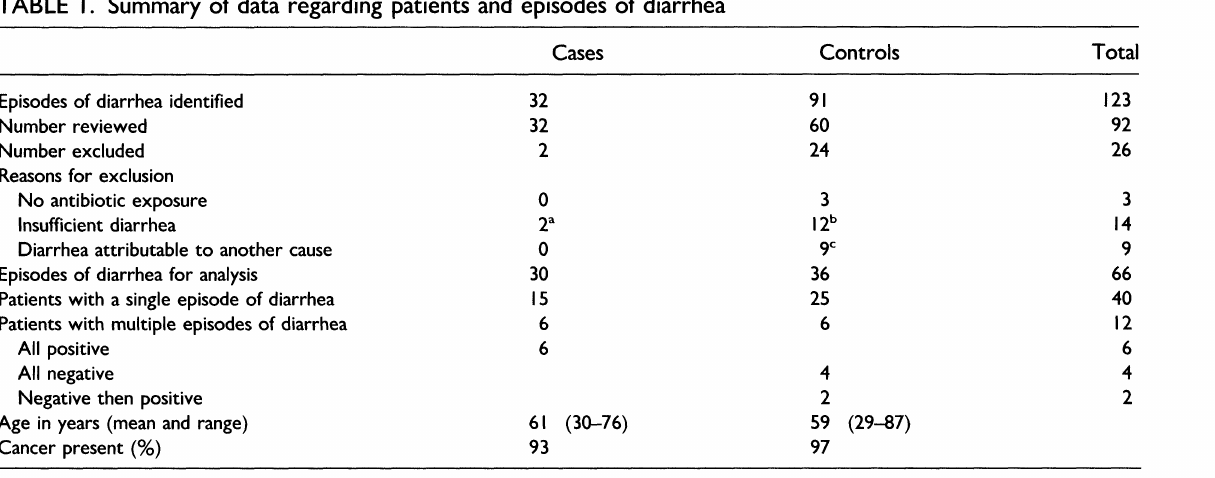
TABLE I. Summary of data regarding patients and episodes of